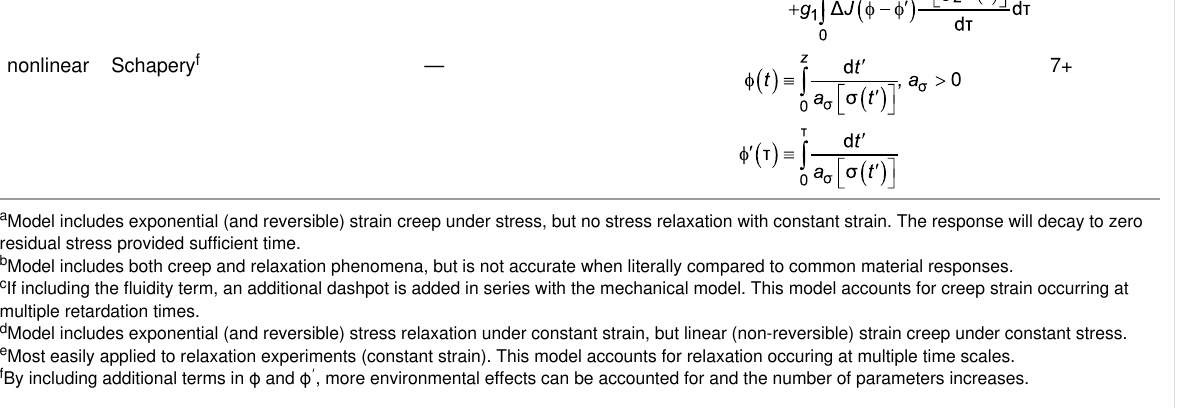
nonlinear Schapery f —